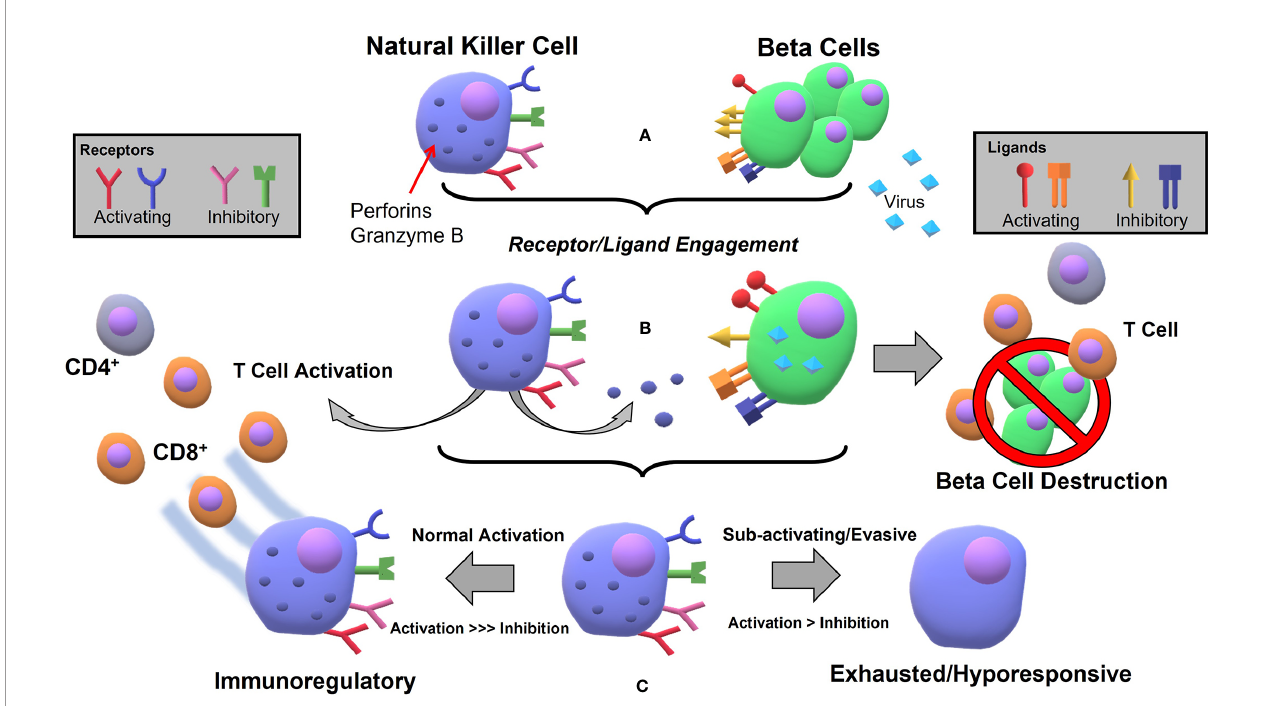
FIGURE 1 | Hypothetical process for NK mediated b cell destruction and subsequent autoimmune T cell reaction following viral infection in pancreatic tissue: (A) Natural Killer cells express several activating (NKp46, NKG2D, some KIRs) and several inhibitory (CD94/NKG2A, KLRG1, KLRB1, some KIRs) receptors for ligands which can be expressed at varying levels on b cells during normal stasis. Ligands include the inhibitory set of MHC-I molecules (e.g. HLA-E) and the activating inducible MIC A/B molecules, constitutively expressed RAE-1/ULBP, and the unknown ligand for NKp46 (B) Viral infection leads to NK activation, cytokine release, whereby adaptive immunity is recruited and NKs degranulate, killing infected cells (C) If the viral infection is at low-level, persistent, or the virus is able to use evasive or immunosuppressive tactics, the NKs will not react appropriately and the immunoregulatory feedback does not occur, leading to exhausted or hyporesponsive state and b cell destruction by